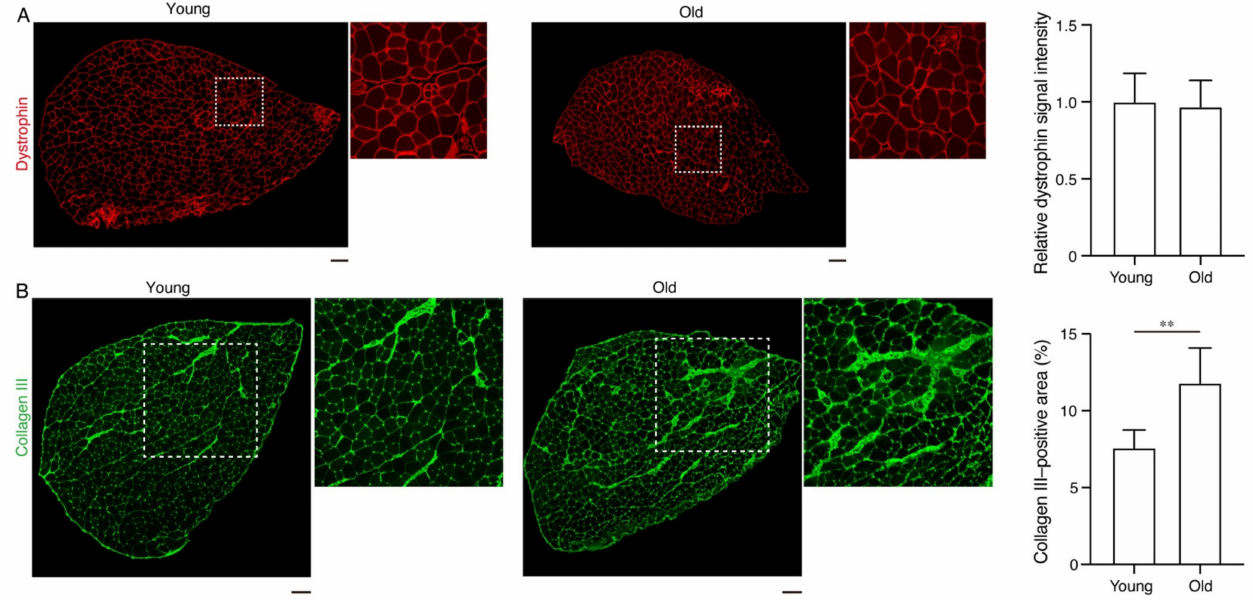
Figure 4. Dystrophin expression and connective tissue volume in the extensor digitorum longus (EDL) muscle. ( A ) EDL muscle sections of young and old mice were stained with a dystrophin antibody. The right panels are magnified views of boxed regions in the left panels. Relative dystrophin signal intensity is shown. ( B ) EDL muscle sections of young and old mice were stained with an antibody against collagen III. The right panels are magnified views of boxed regions in the left panels. The percentage of the collagen III-positive area is shown. Data are expressed as means ± standard deviation; the two-sided unpaired t -test. n = 5 mice per group. ** p < 0.01. Scale bars: 100 µ